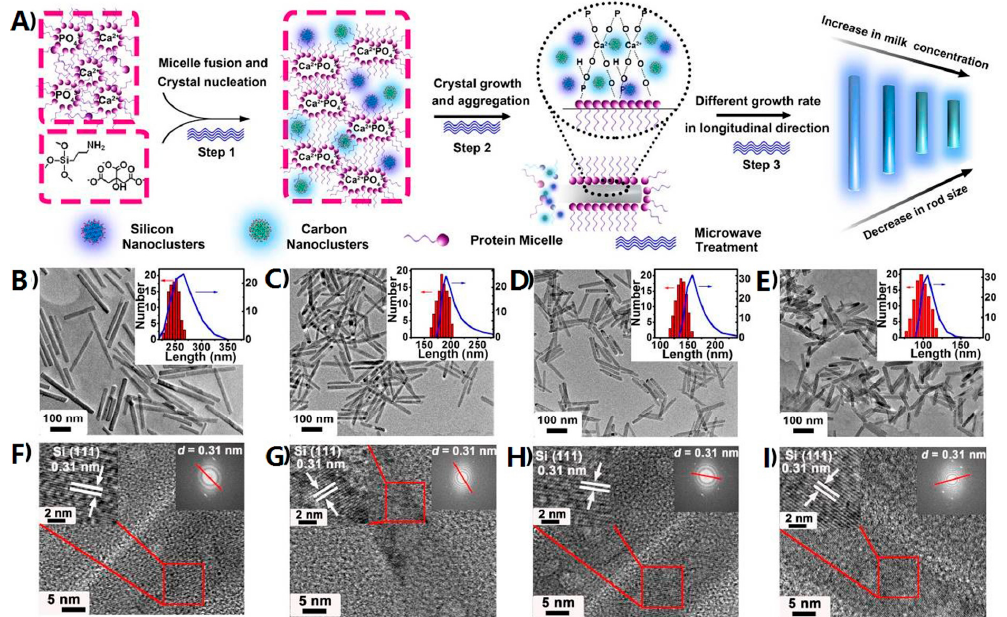
Figure 3. ( A ) Schematic illustration of the whole growth process of SiNRs; ( B – I ) TEM and HRTEM images of silicon nanorods (SiNRs) with different lengths: ( B , F ) 250 nm; ( C , G ) 180 nm; ( D , H ) 140 nm; and ( E , I ) 100 nm at different milk concentrations ranging from 1 to 4 mg/mL. Insets in ( B – E ) represent corresponding length distribution analysis (histograms) determined by TEM and dynamic laser light scattering (DLS) spectra (blue curves). Reproduced with permission from [47]. Copyright 2016, American Chemical Society.